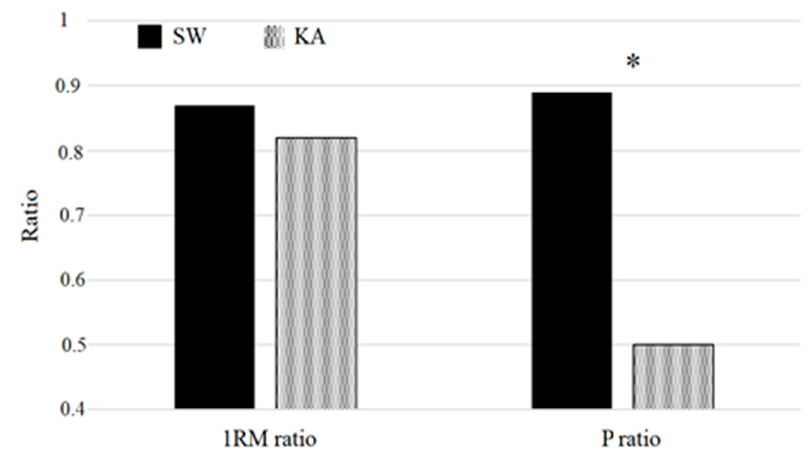
Figure 3. Maximum strength (1RM) and P ratio in the KA and SW groups. 1RM ratio = 1RM PR/1RM PU; P ratio = PRAUC/PUAUC. KA = kayak group; SW = swimming group. * indicates a significant difference ( p < 0.05) between the groups.